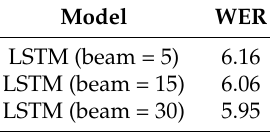
Table 10. WER of models with different beam parameters trained and tested on clean